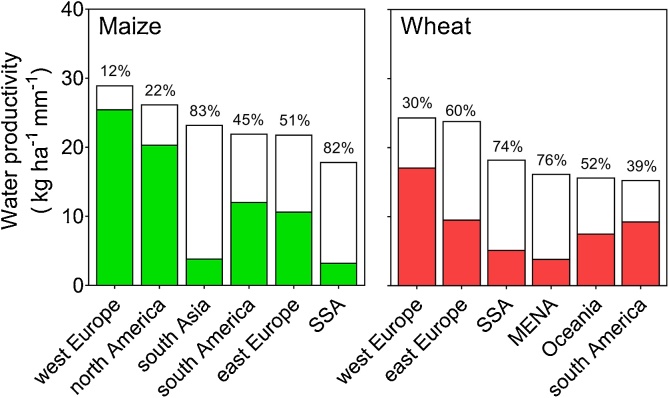
Average (10–20 years) water-limited potential water productivity for rainfed maize and wheat across producing regions: north and south America, west and east Europe, sub-Saharan Africa (SSA), south Asia, Oceania, and Middle East and North Africa (MENA). The colored portion of the bars indicates the actual water productivity and the open portion represents the water productivity gap. The water productivity gap, expressed as a percentage of WPw, is shown above bars.